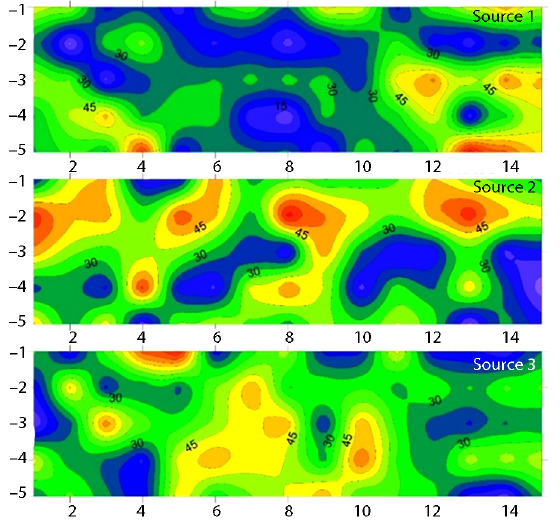
Figure 4. Spatial distributions of source contributions (%)